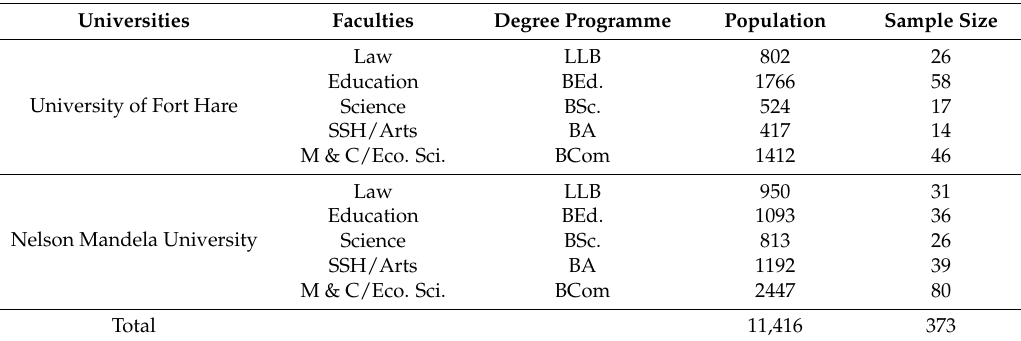
Table 1. Selected universities, faculties, population and sample